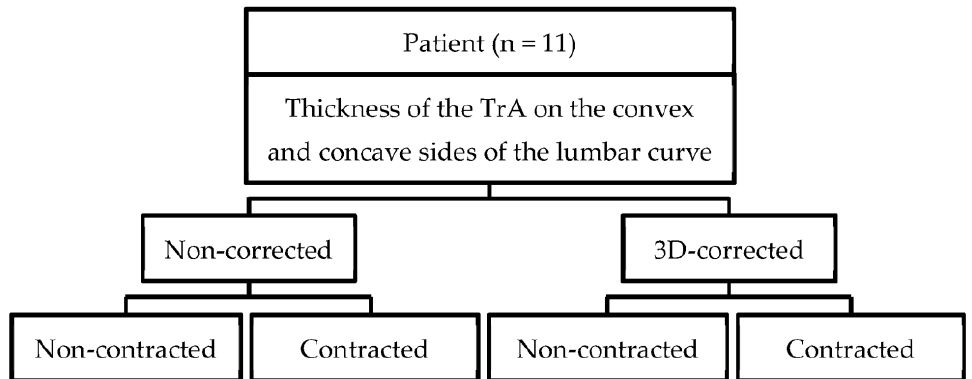
Figure 1. Diagram of the design of the first experiment. To measure the TrA thickness, the perpendicular distance of the TrA at a site 1.5 cm away from the muscle fascia junction was measured on captured images using Image J (National Institutes of Health, Bethesda, MD, USA) [17,19,39,40]. The TrA symmetry ratio was calculated as TrA thickness on the convex side of the lumbar curve/TrA thickness on the concave side of the lumbar curve (Figure 2).